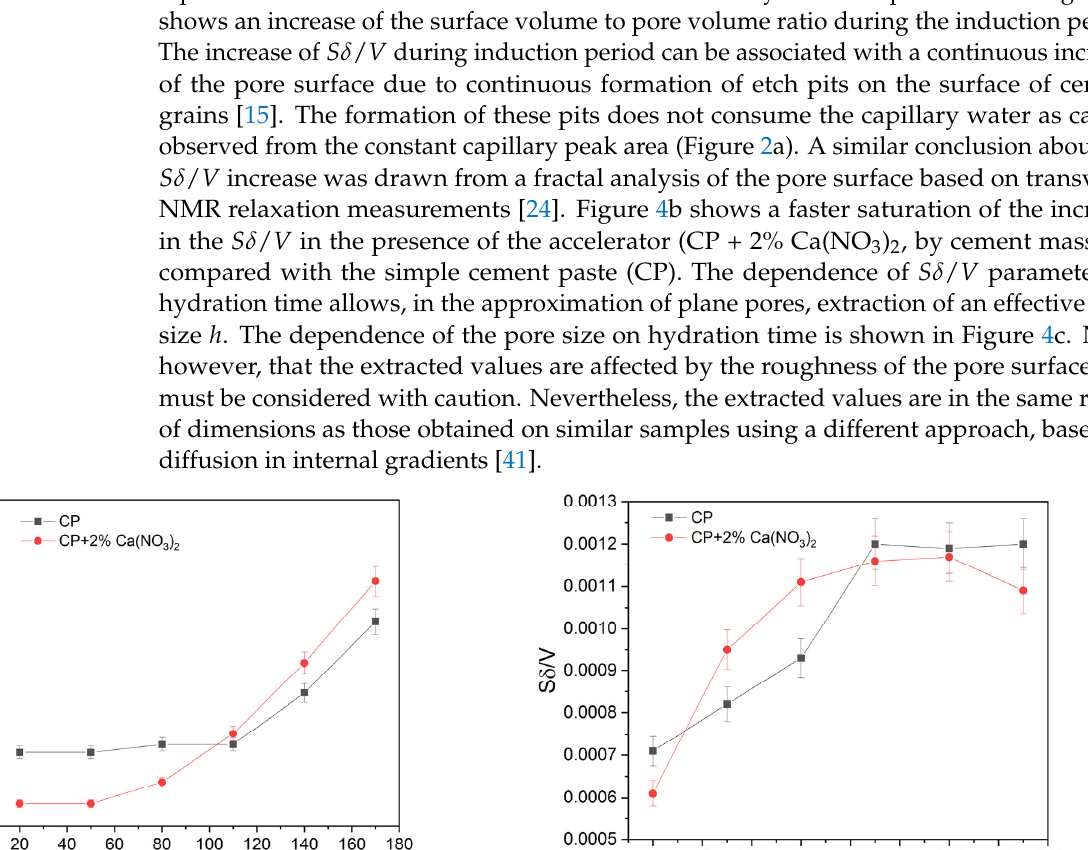
Figure 4. The fitting parameters, extracted from the data in Figure 3 by using the 3 ‐ Tau model. ( a ) Number density of paramagnetic ions versus hydration time. ( b ) The ratio the ratio between the volume of the surface layer and the pore volume versus hydration time. ( c ) The pore size versus hydration time in the approximation of plane pores. 3. Materials and Methods 3.1. Sample Preparation Two cement ‐ based samples were prepared using white Portland cement (CEM I 52.5R Holcim, Romania), for a water ‐ to ‐ cement ratio of 0.4, by weight. The chemical com ‐ position of the cement powder was determined in Ref. [23] and is specific to a white